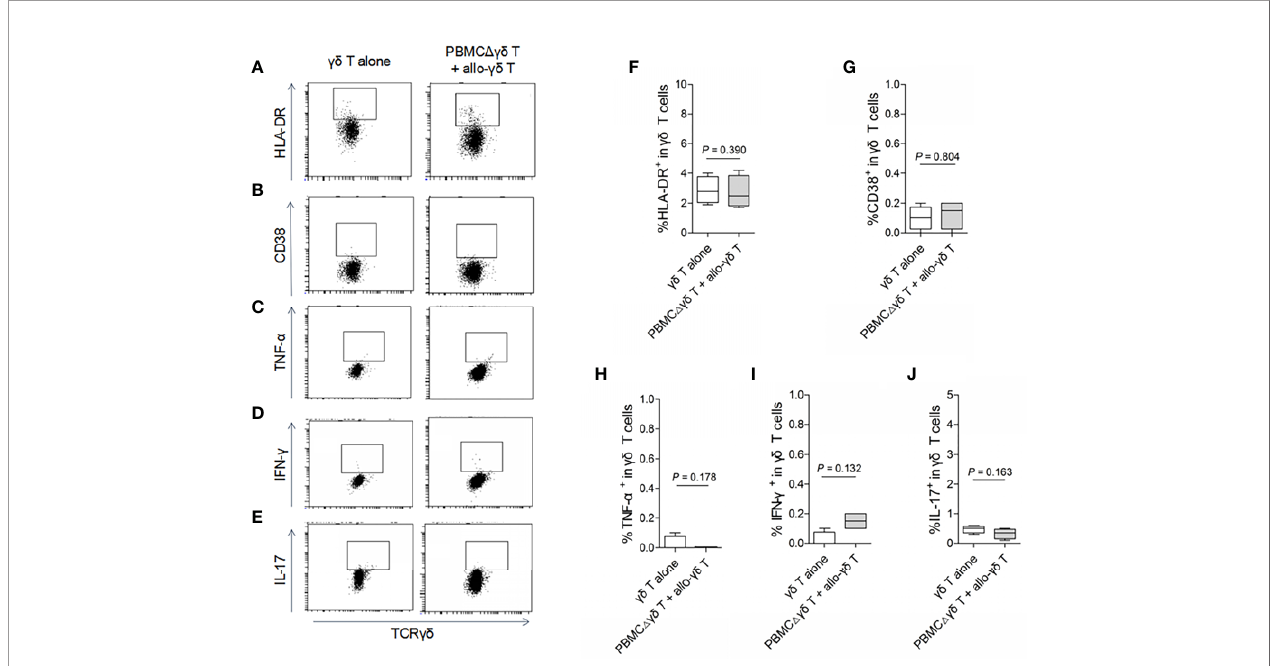
FIGURE 1 | Assay for the reactivity of gd T cells in response to stimulation of allogeneic ab T cells. Mixed lymphocyte reactions (MLRs) were performed by co- culture of puri fi ed allogenic gd T cells with PBMCs depleted of gd T cells (PBMC Dgd T cells) isolated from healthy donors, at a ratio of 1:3. Cells were collected on day 5 after co-culture and stained with antibodies against gd TCR (A – J) , HLA-DR (A, F) , CD38 (B, G) , TNF- a (C, H) , IFN- g (D, I) and IL-17 (E, J) . Data are expressed as the mean ± SD of triplicate cultures. P values are shown on the